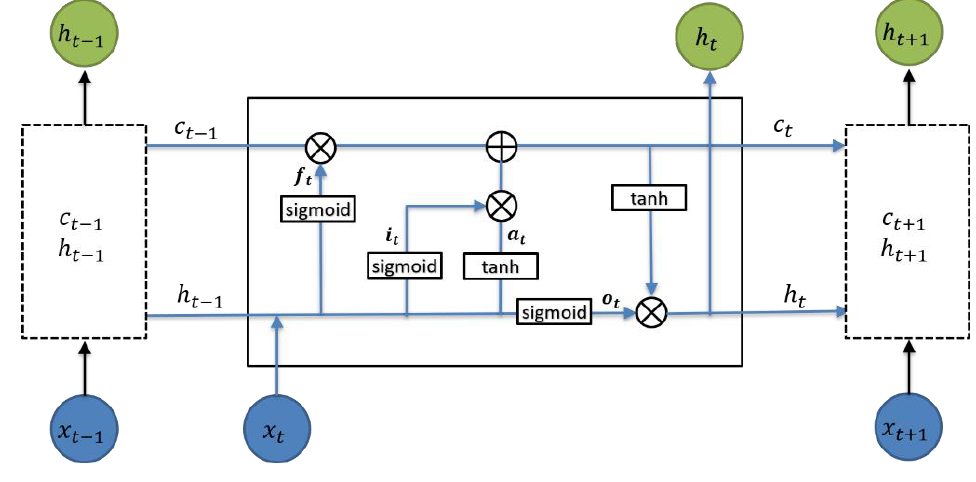
Figure 3. LSTM model.